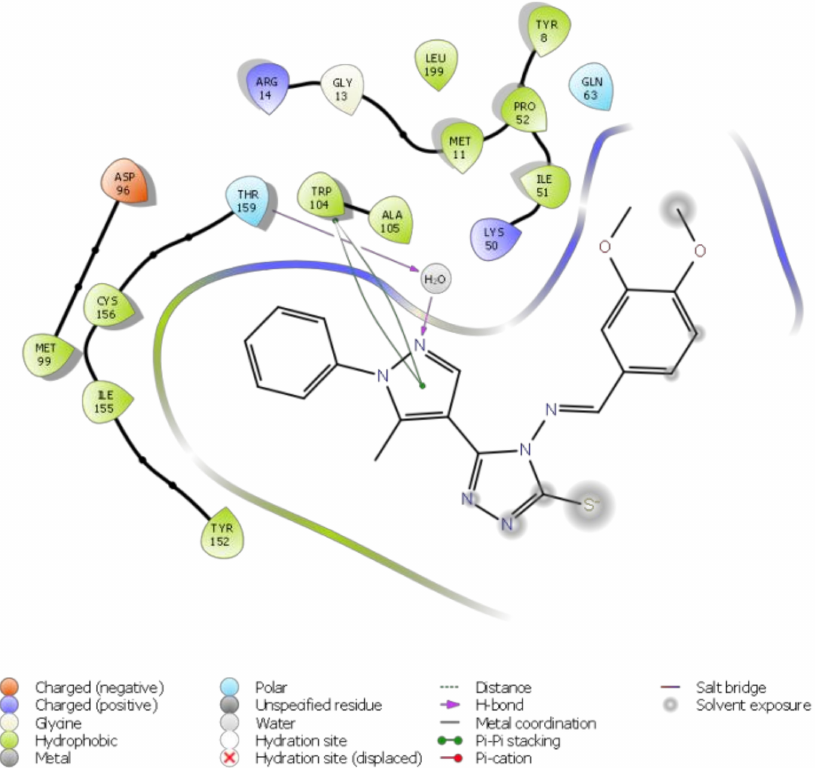
Figure 1. 2D ligand interaction diagram of the title compound 2 with human prostaglandin reductase (PTGR2).